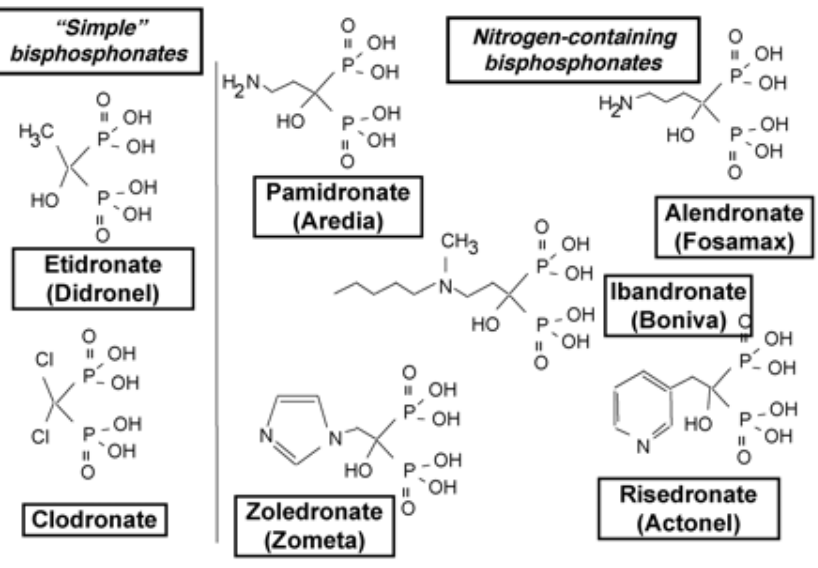
FIGURE 1 . Chemical structure of the nitrogen-containing and non-nitrogen-containing bisphosphonates. Adapted from Russell,